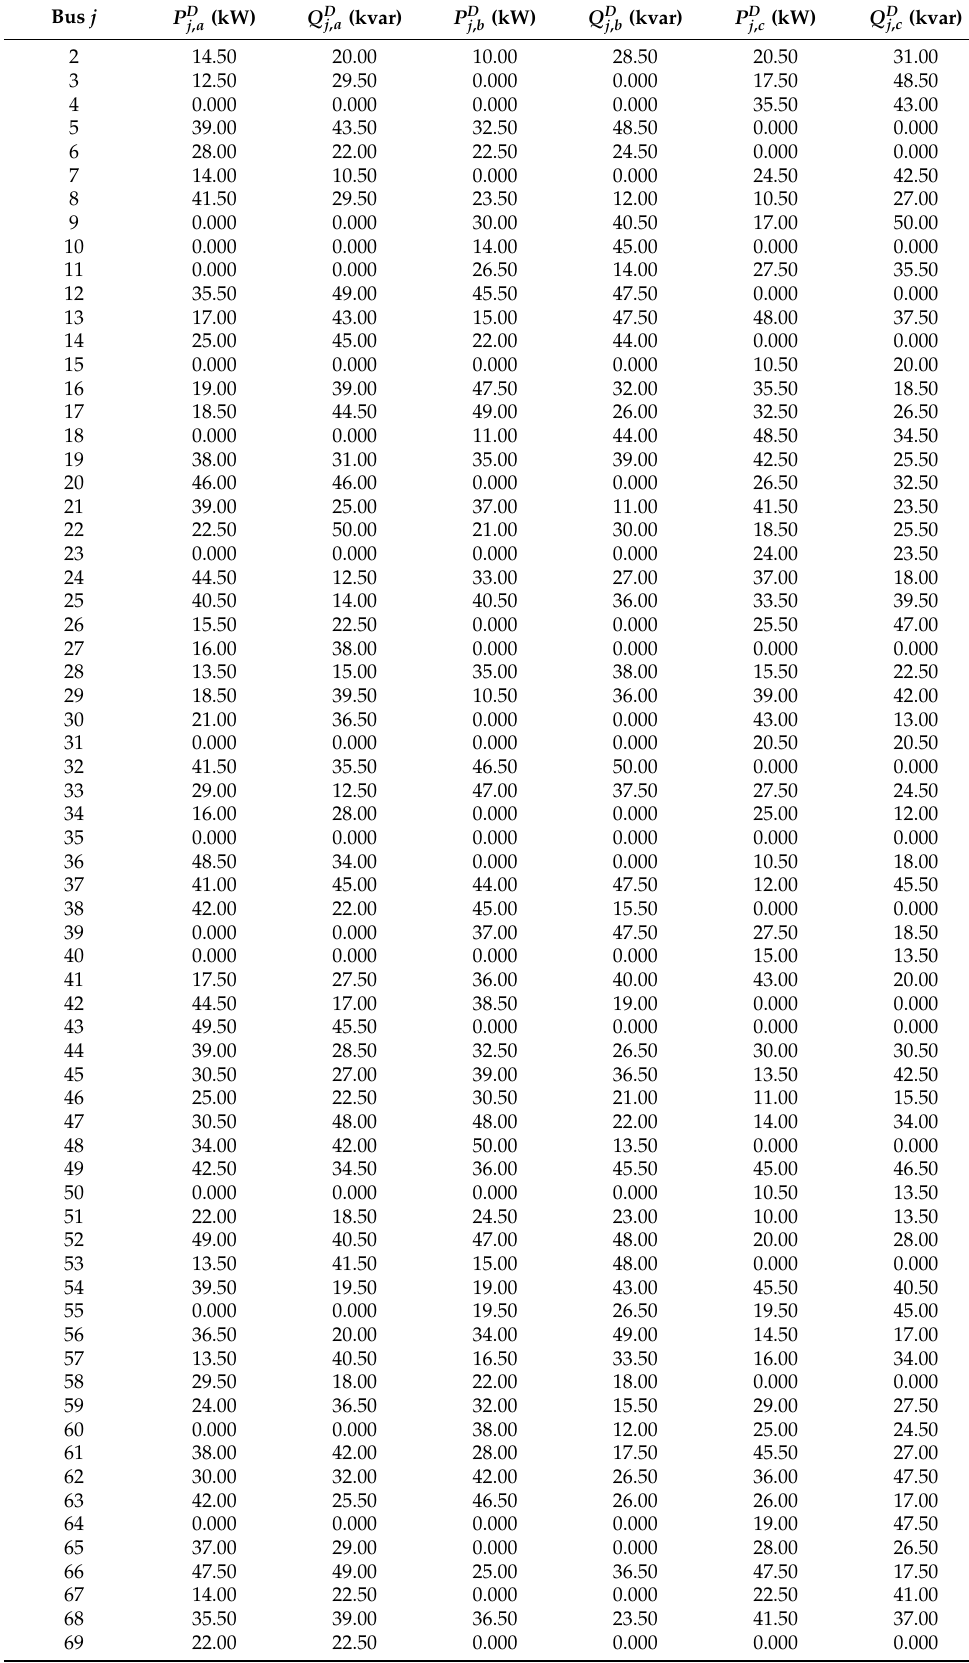
Table 14. Load for each phase in the 85-bus test